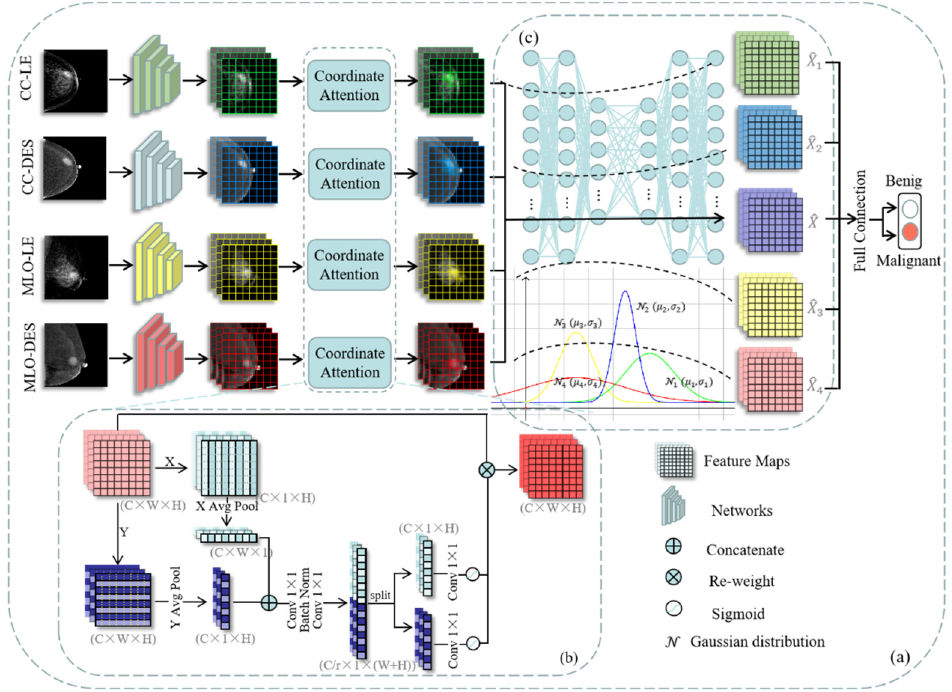
Figure 2. The overview of contextual features and information bottleneck-based multi-input network for breast cancer classification. ( a ) shows the overall flowchart. ( b , c ) show the details of the feature extraction module and feature selection module, respectively.